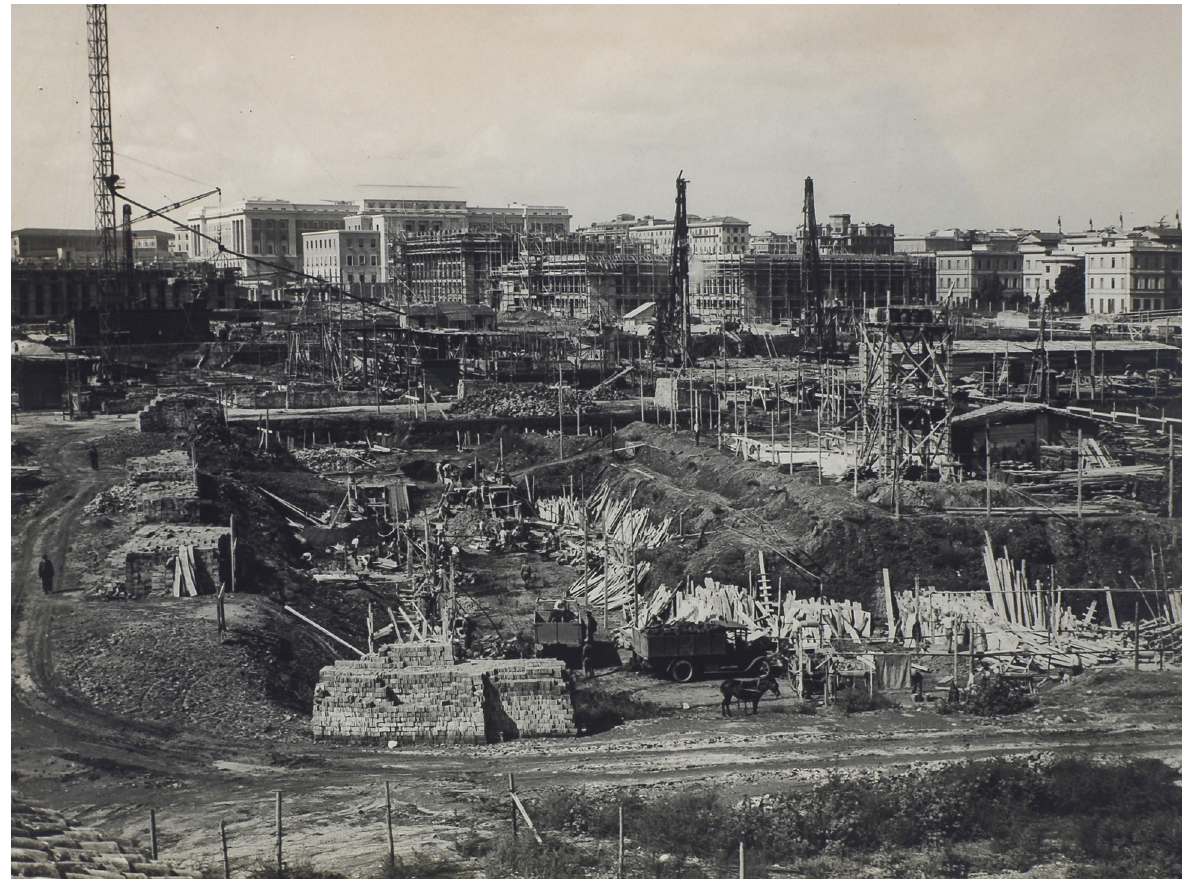
Fig. 6. Excavations for the foundations of the Sapienza Campus buildings, July 1933. (Author: unknown. Source: Sapienza Historical